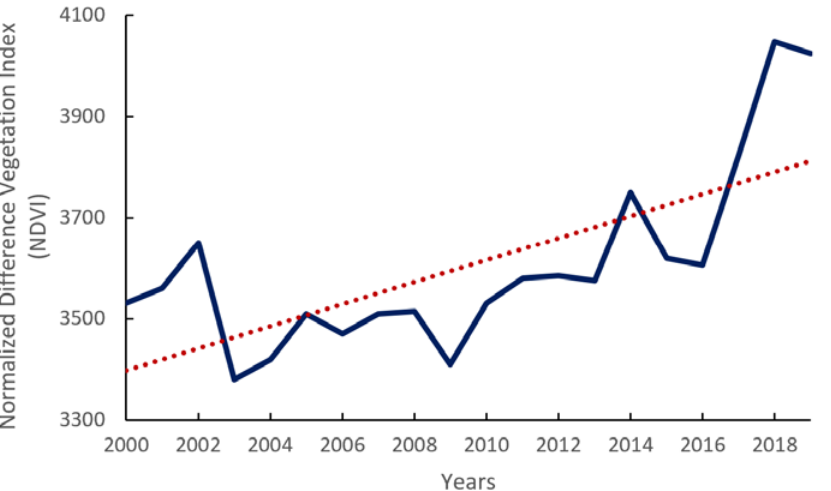
Figure 6. Normalized Difference Vegetation Index (NDVI) trend from 2000 to 2019, in Great Khin- gan Mountain (GKM), China.